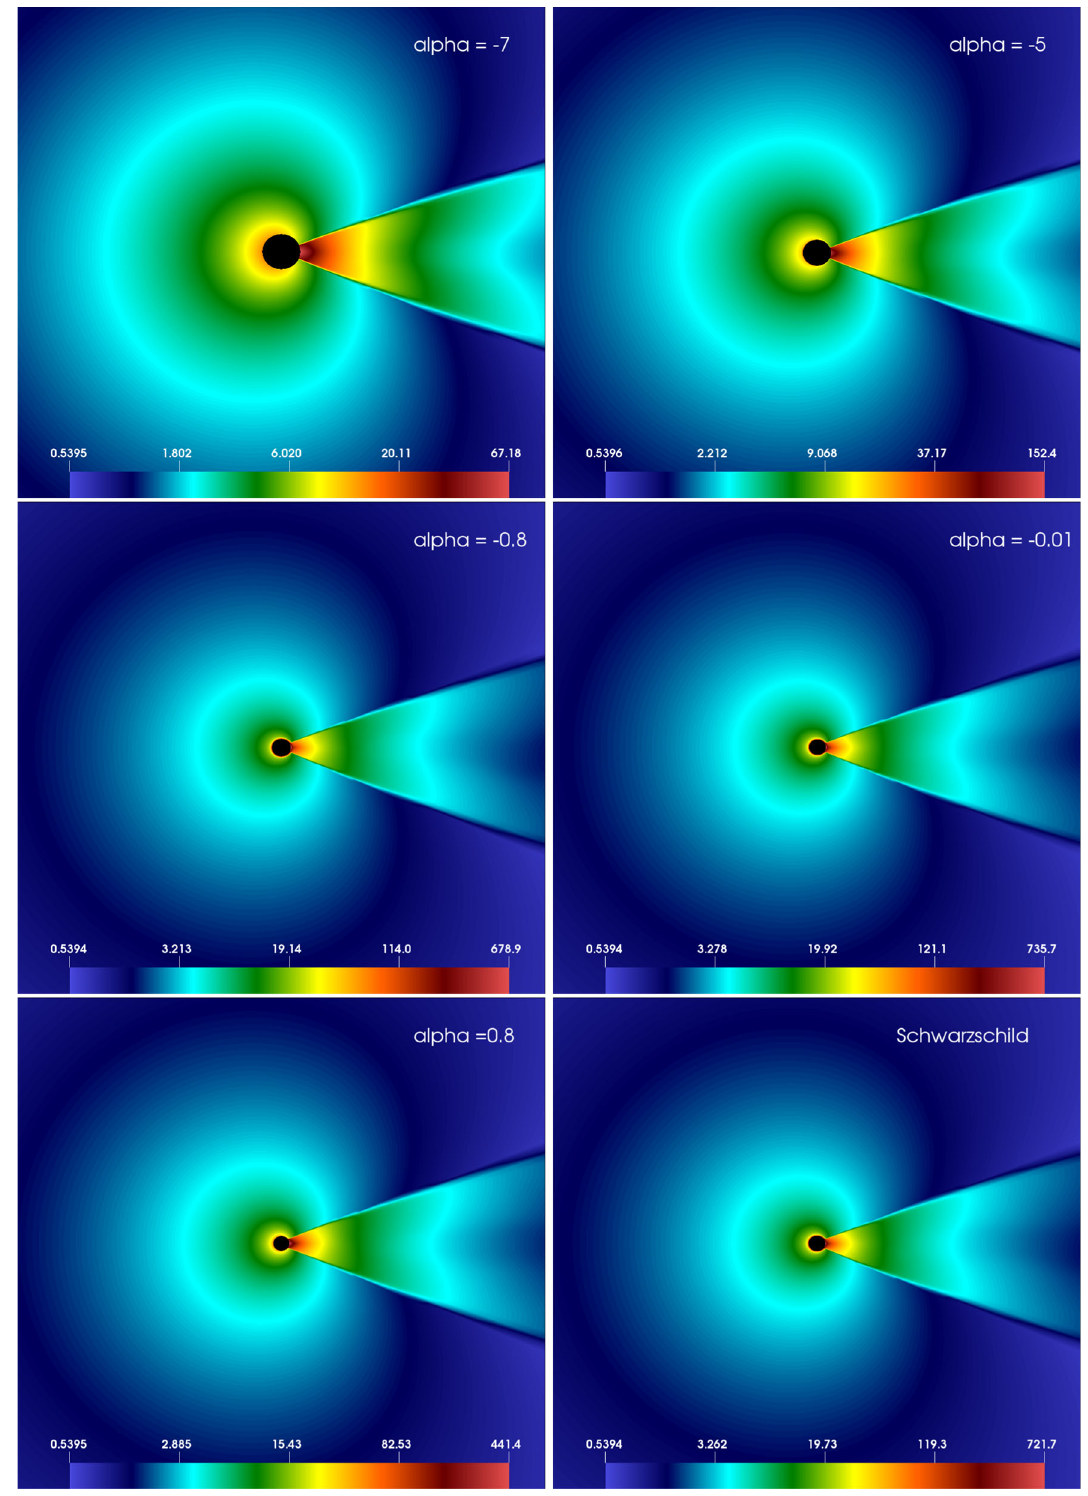
Fig. 3 Close-up view of the snapshots of the logarithmic rest-mass density on the equatorial plane at t ∼ 15000 M much later than the shock cone reached the steady state t ∼ 1900 M for varying values